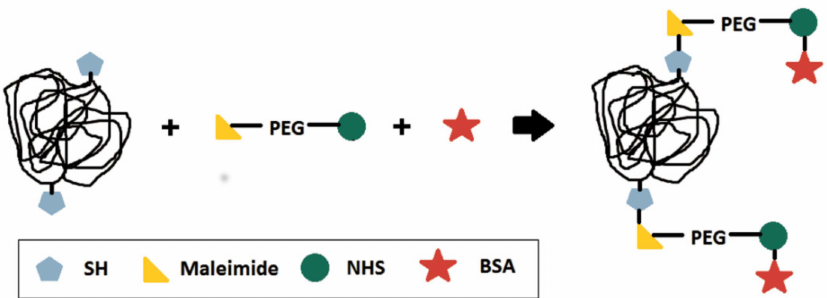
Figure 1. Scheme of the multistep bioconjugation reactions performed in the present work